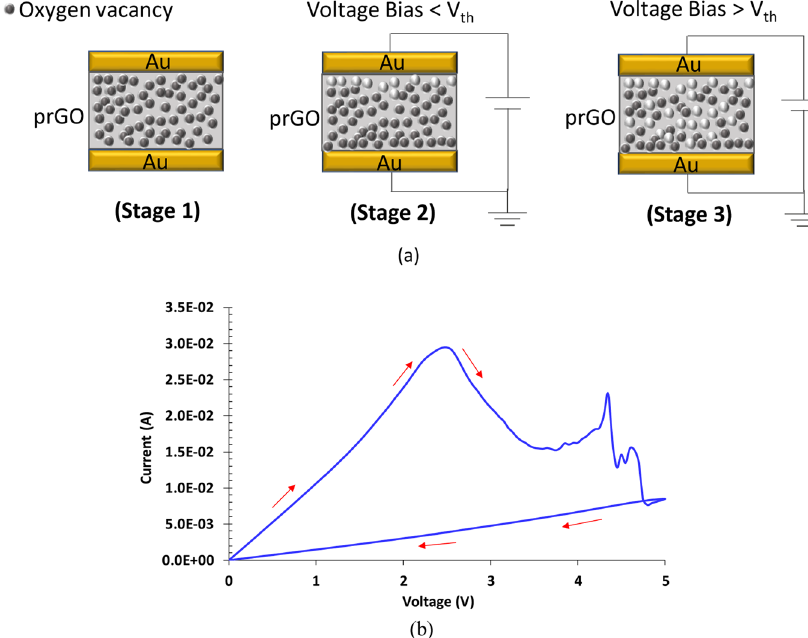
Figure 4. Switching Mechanism of NeuroMem. ( a ) Schematic representation of the switching phenomenon occurring in NeuroMem; (stage 1) pristine stage, (stage 2) after applying voltage of magnitude: Voltage Bias < Vth, (stage 3) after applying consecutive voltage sweeps of increasing magnitude: Voltage Bias > Vth. Dimensions are for illustration purposes. ( b ) A chart illustrating the measured I-V across NeuroMem fresh device with gap of 20 µ m under vacuum (i.e. pressure = 5 × 10-5